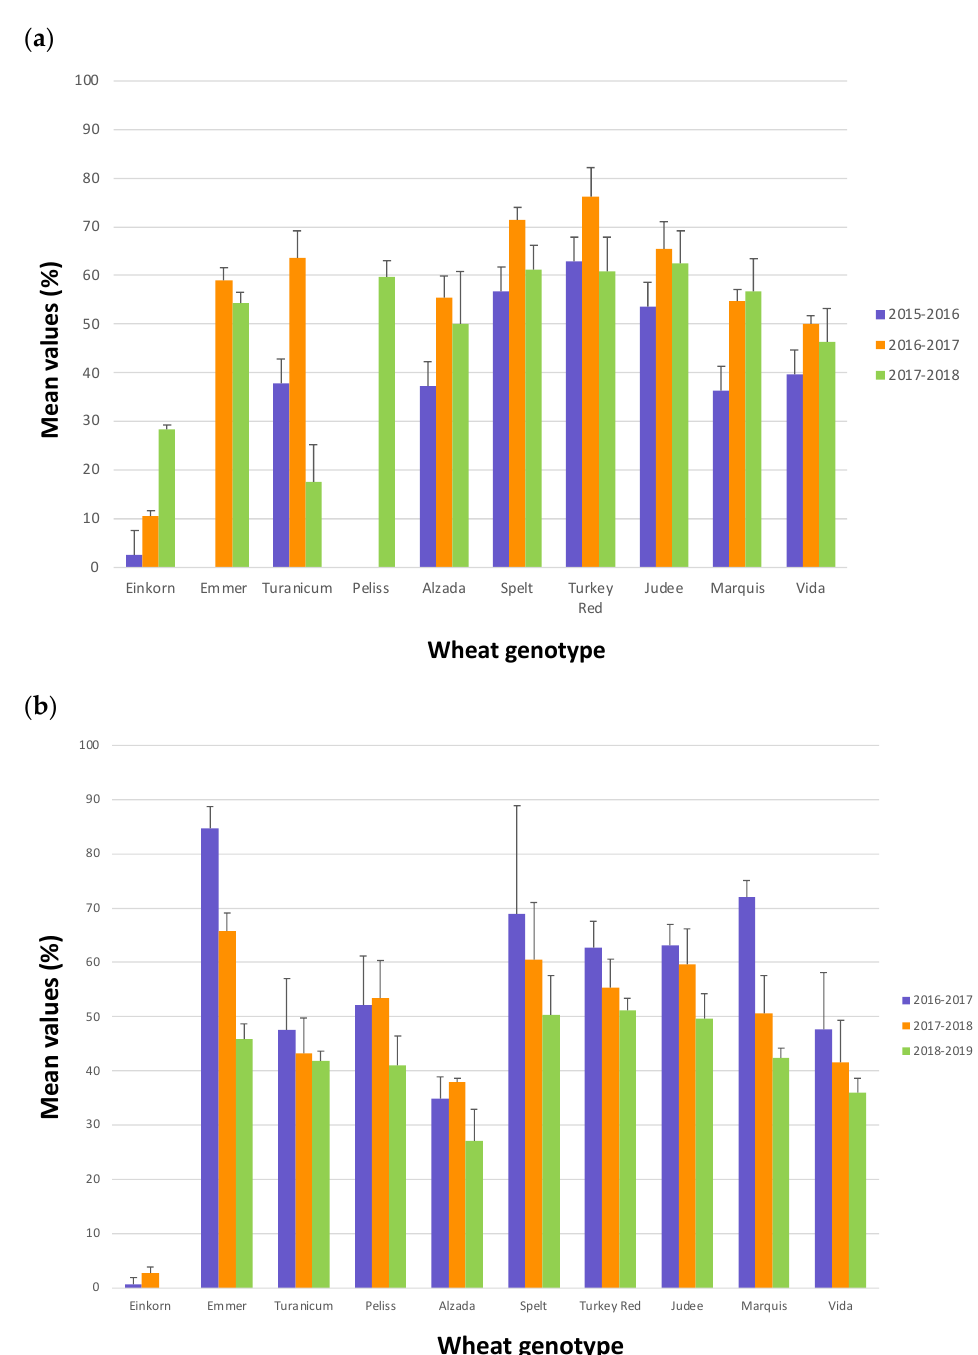
Figure 2. Mean values of the alpha-amylase inhibitory activity for each genotype in the three crop years. Samples grown in the USA ( a ); samples grown in Italy ( b ). The bars in the graph indicate the standard error (SE).